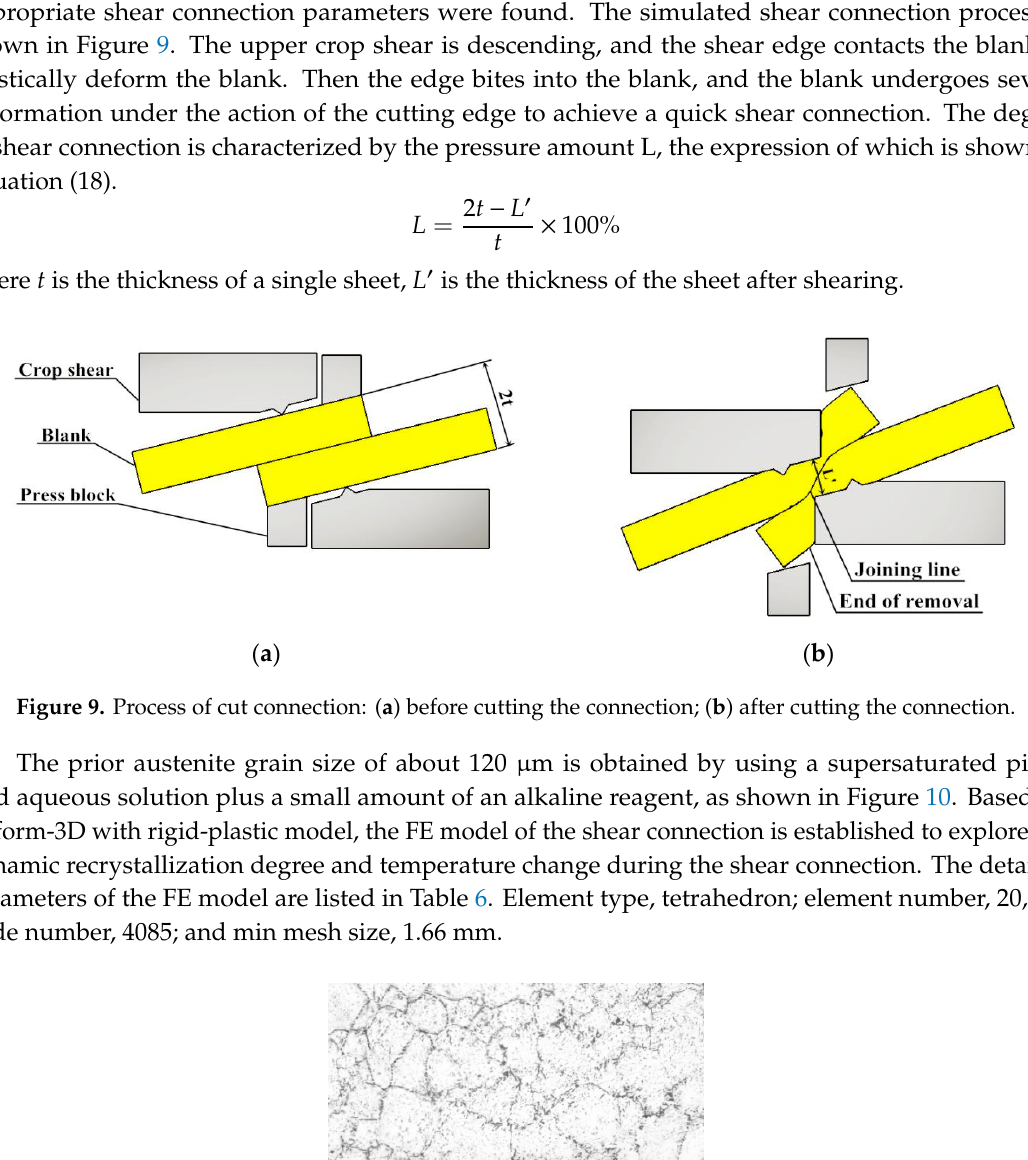
( b ) Figure 8 . Linear regression results of dynamic recrystallization equation: ( a ) ln ε p -ln ε  ; ( b ) ln ε p -1/T. 3. Finite Element (FE) Analysis of Shear Connection Process Development of Deform-3D (Version: Deform6.01) Software Developed by SFTC Company in